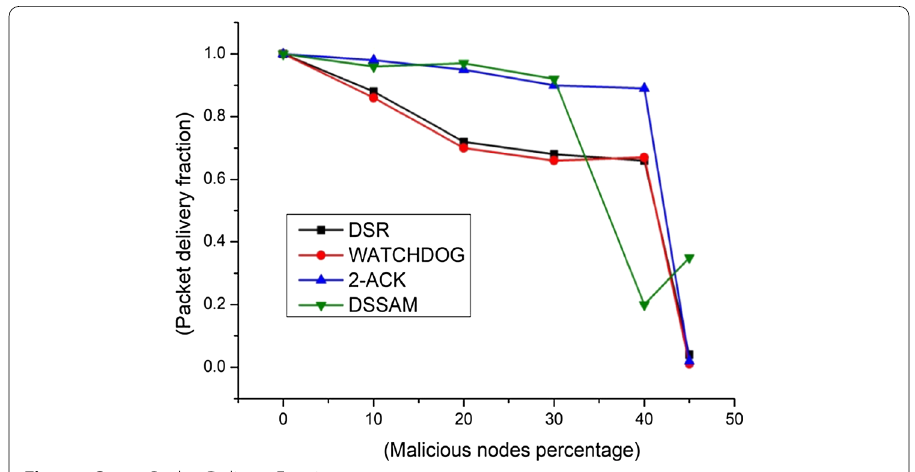
Fig. 11 Case 1-Packet Delivery